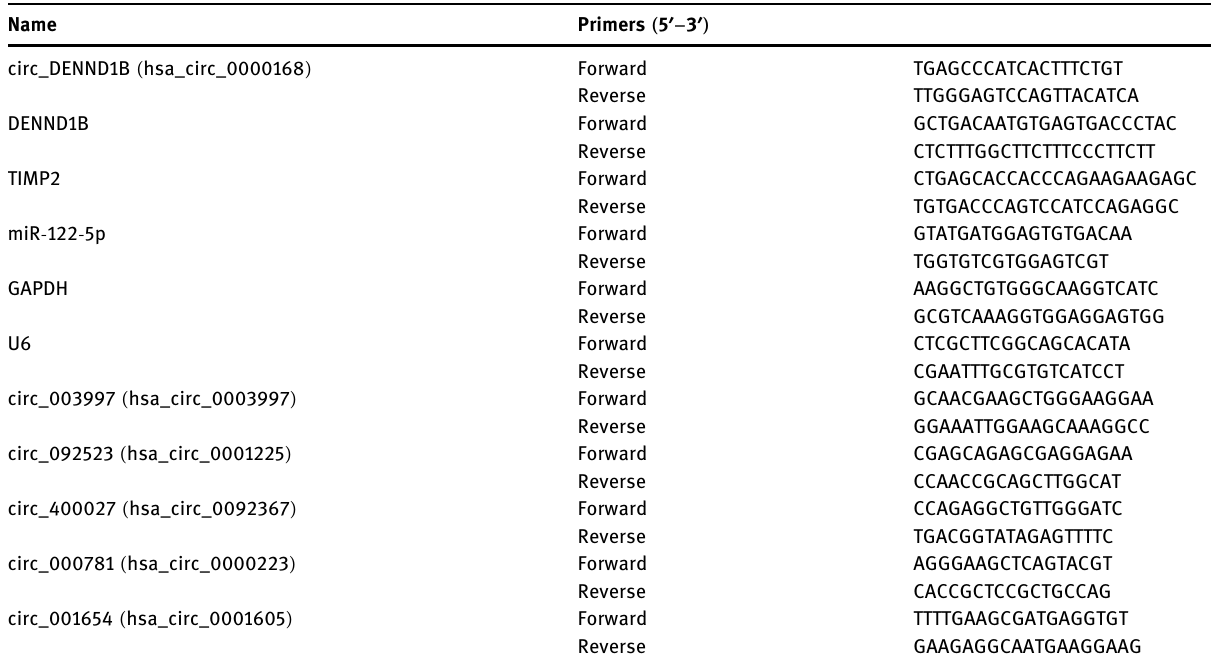
Table 1: Primer sequences for qRT - PCR